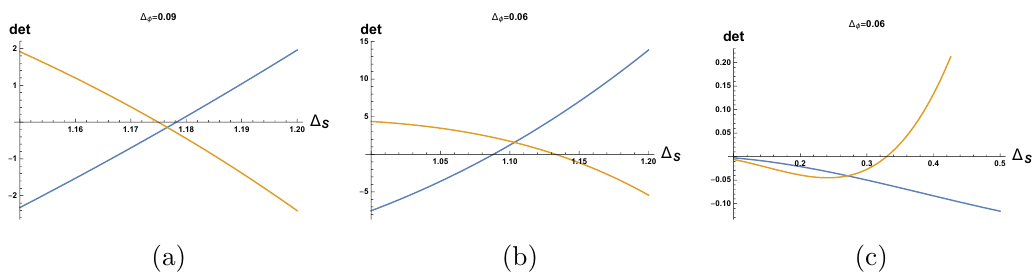
Figure 10. Plots of det 3 ; det 4 as a function of (cid:1) S . The blue plot is for det 3 while the orange plot is for det 4